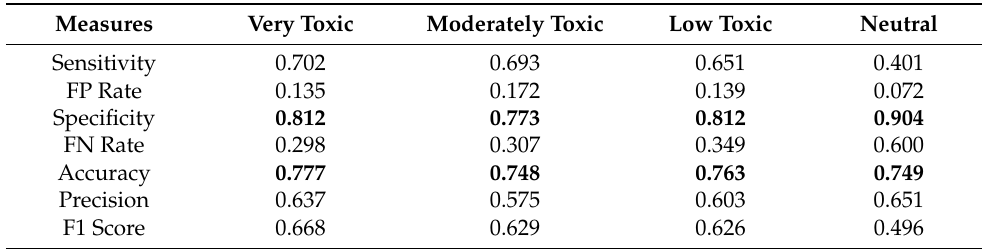
Table 4. Effectivity of Naïve Bayes Multinomial model for recognition of four degrees of toxicity in online discussions.